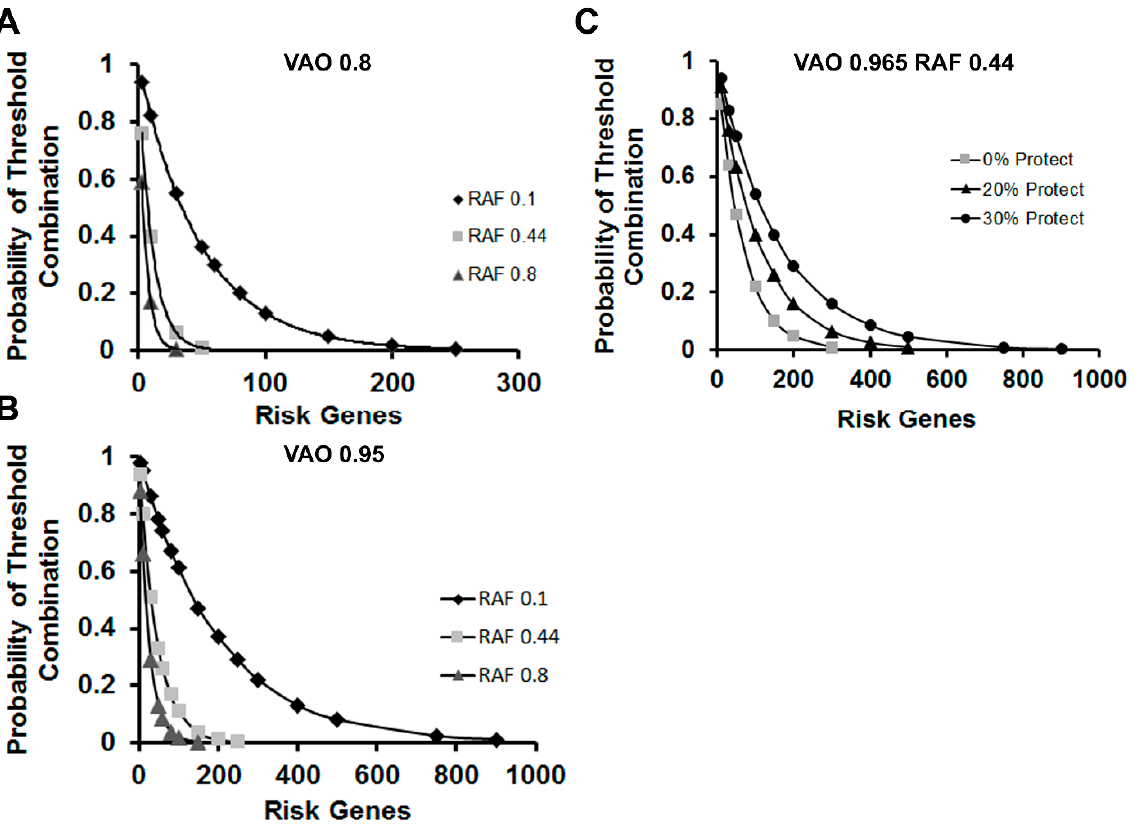
Figure 3. Risk-gene estimation. Graphs were rendered for the number of risk genes required to reach the 0.01 probability of threshold risk-gene combination in the population ( P t ) from pairs of alleles associated with risk polymorphisms. The VAOs are labeled as 0.8 ( A ) and 0.95 ( B ). The average RAFs used in Equation (2) are indicated in the inset legends. ( C ) Estimation of risk alleles needed to reach threshold with protective variants included either 20% or 30% of the total (as labeled). We assumed that the protective variants had a VAO of 1.035 with a resulting FLO of 1.015, which was equal in magnitude, but opposite in effect from the VAO of 0.965 (FLO = 0.985) for adverse risk variants.